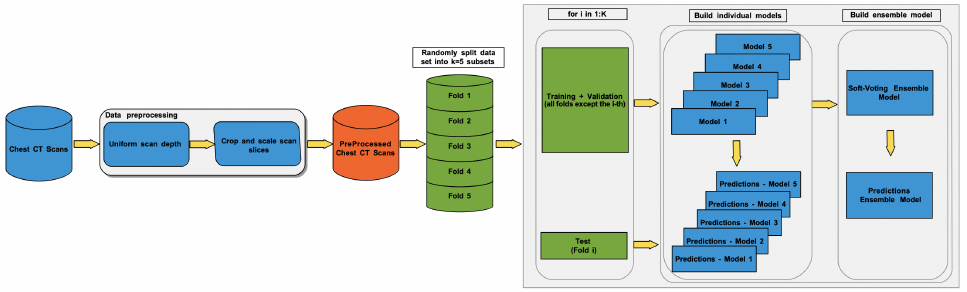
Figure 4. The main steps of the proposed approach. Basically, it consists of steps aimed at pre- processing the dataset, splitting it to perform a 5-fold cross-validation, buiding and assessing the individual models, and compositing them using a voting ensemble